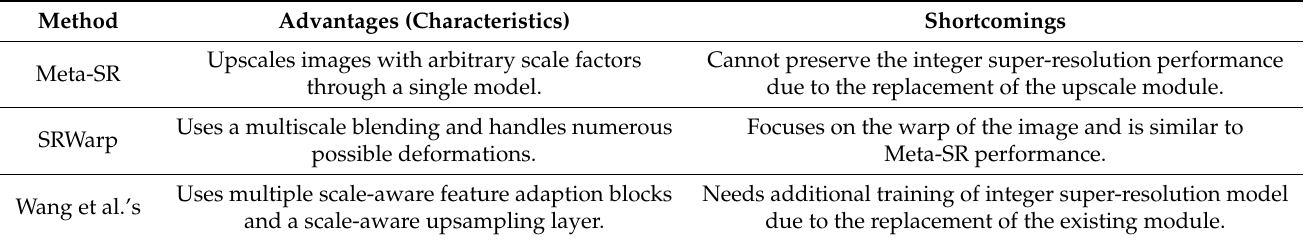
Table 2. Arbitrary magnification single image super-resolution methods’ advantages and